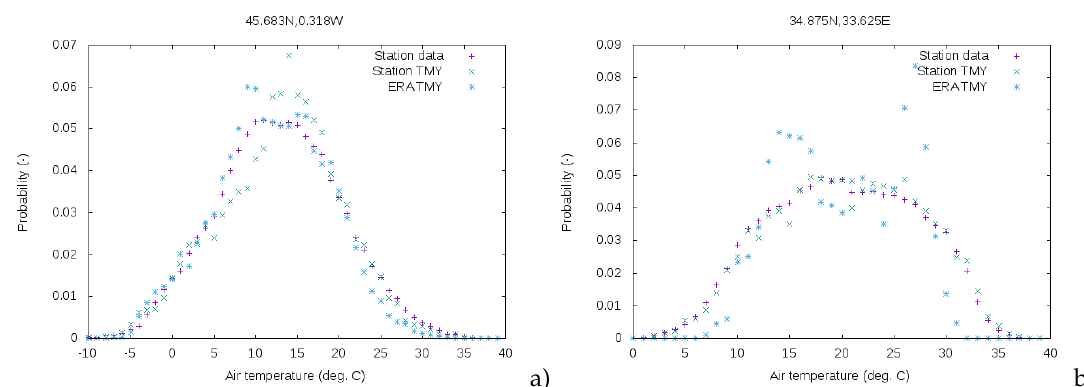
Figure 8. Probability density functions (PDF) of air temperature for two different locations with low relative deviation in calculated heating loads ( a ), and high deviation ( b ). The PDFs are shown for the full station data, the station-based TMY, and the ERA-based TMY.